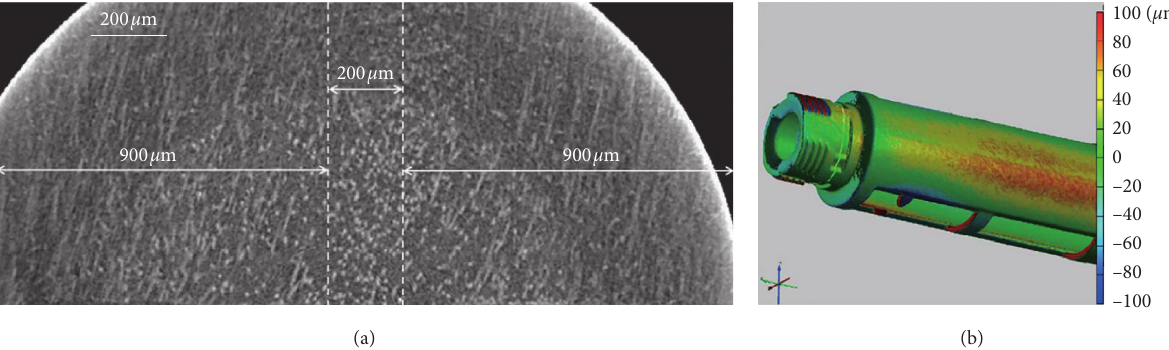
Figure 7: (a) Fiber orientation of the GF/PA6 specimen shown by the longitudinal section X-ray CT image [64]. (b) Comparison with the CAD model of an injection molded cartridge holder [61].